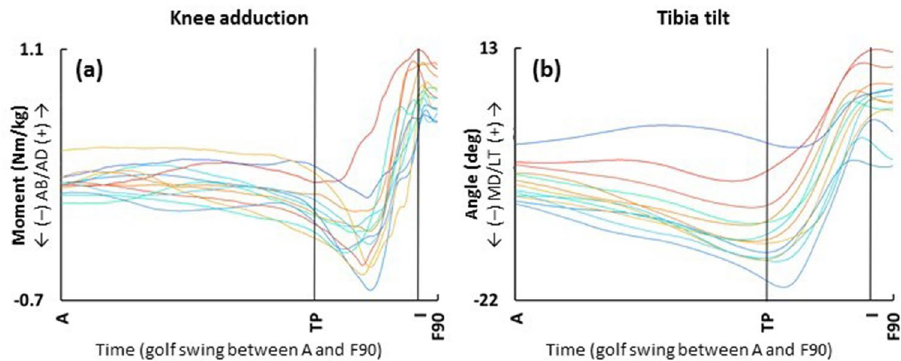
Figure 2. Frontal plane knee add/abduction moment and tibial medial/lateral tilt of the lead leg during the golf swing. Each line represents the mean trajectories of each participant over 5 shots for ( a ) knee add/abduction moment and ( b ) tibial medial/lateral tilt of the lead leg. The gradation of colors in warm and cool represent the high and low knee adduction moment at its peak, respectively. Direction of knee adduction moment (the tibia segment with respect to the thigh segment) and tibial lateral tilt (the tibia segment relative to laboratory) of the lead leg represents positive value. A: address, TP: transition of pelvis, I: impact, F90: follow-through